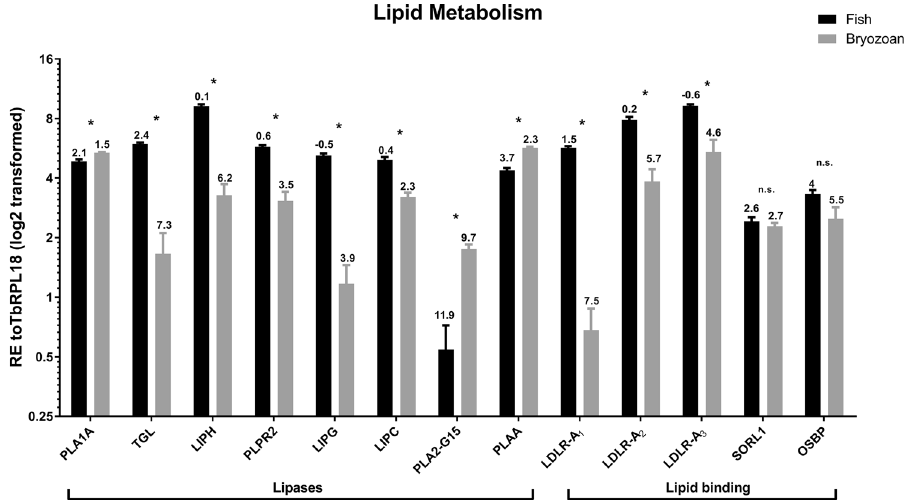
Figure 6. Average relative gene expression in infected bryozoan and infected fish kidney tissues of representative T. bryosalmonae genes involved in lipid metabolism. All gene values were normalized to Tb RPL18. Δ Cq values, stated above each bar, represent the expression level of genes of interest relative to Tb RPL18 in each infected host with values > 1 indicating lower expression and values < 1 indicating higher expression relative to Tb RPL18. * P < 0.05. Black bars = infected fish, grey bars = infected bryozoan. Gene abbreviations: phospholipase A1 member A-like (PLA1A), Triacyl glycerol lipase (TGL), Lipase Member H-like (LIPH), Pancreatic lipase-related protein 2 (PLPR2), Endothelial lipase (LIPG), Hepatic triacyl glycerol lipase (LIPC), Group XV phospholipase A2 (PLA2-G15), Phospholipase A-2-activating protein (PLAA), Low-